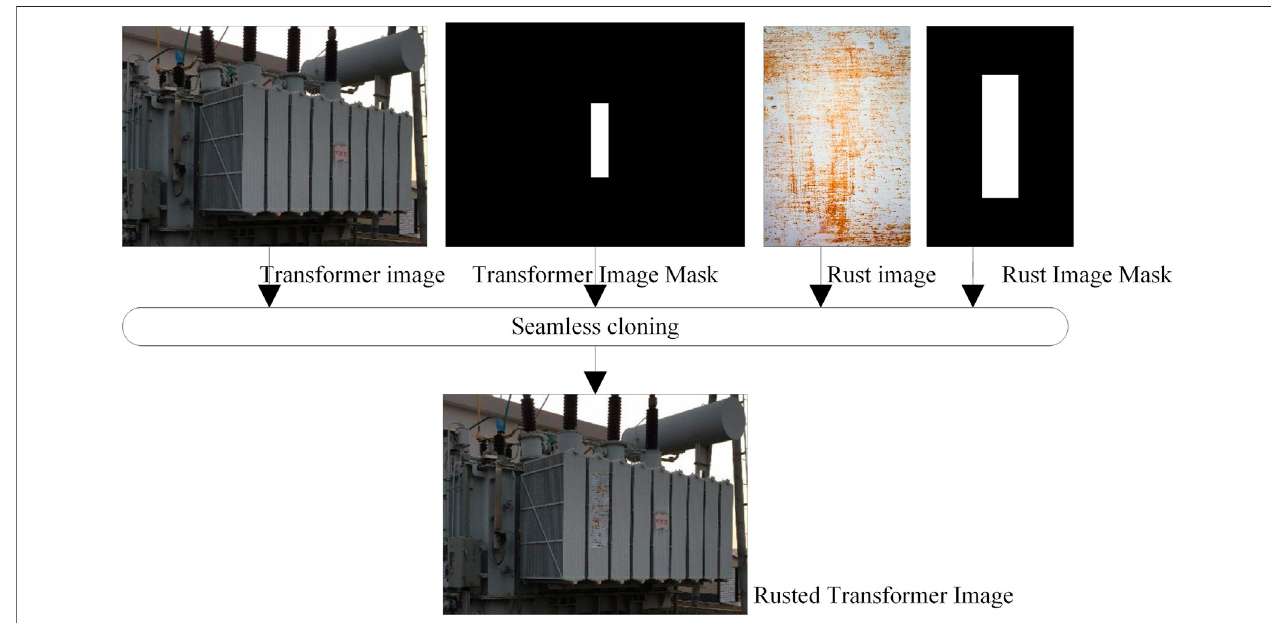
FIGURE 3 | Transformer corrosion sample generation method based on seamless image editing algorithm.